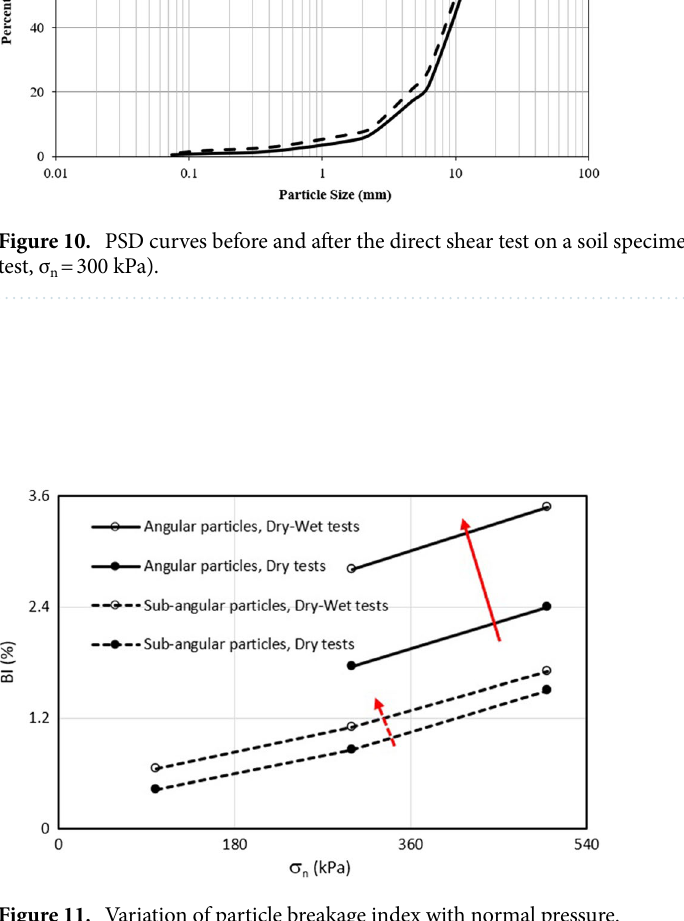
Figure 11. Variation of particle breakage index with normal